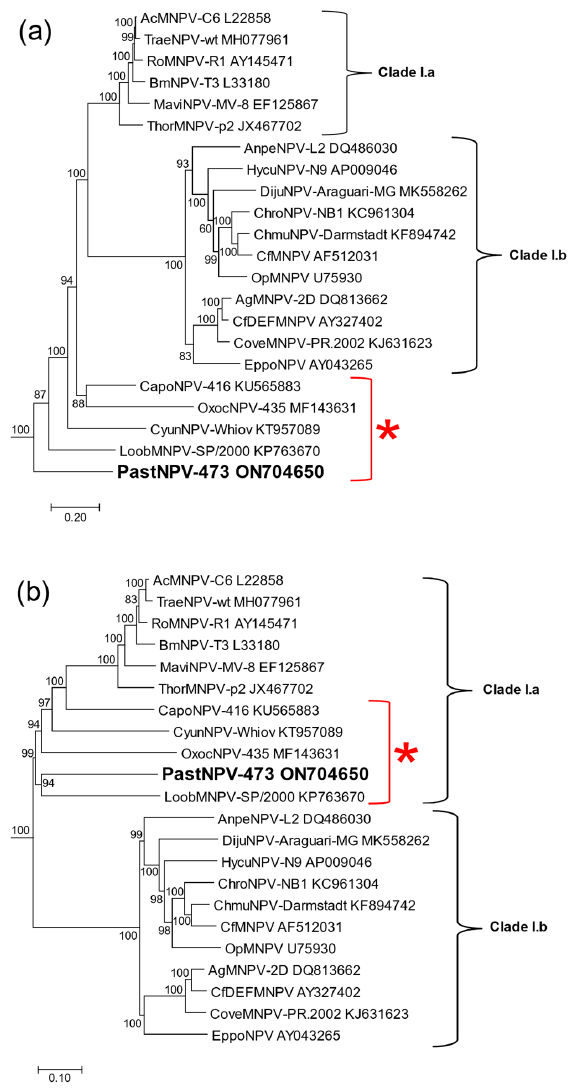
Figure 3. Phylogeny of alphabaculoviruses in the group I clade. ( a ) A subtree of the group I alphabaculoviruses, derived from a phylograms inferred from concatenated MAFFT alignments of baculovirus core gene amino acid sequences by maximum likelihood. ( b ) A subtree of group I alphabaculoviruses derived from a phylogram inferred from MUSCLE alignments of baculovirus core gene amino acid sequences inferred by minimum evolution. Both subtrees show the level of bootstrap support for each branch. Abbreviations and Genbank accession numbers of viruses in the tree are provided; the viruses used in this analysis are listed in Table S1. Clade I.a and I.b are indicated by brackets, and a red bracket and asterisk denotes a group of five alphabaculoviruses with variable placement in the ( a , b ) group I subtrees. PastNPV-473 is indicated in bold type. The branch lengths in all three phylograms suggested that PastNPV represents a new species in genus Alphabaculovirus . The ranges of Kimura-2-parameter pairwise nucleotide distances in alignments of lef-8 , lef-9 , and polh between PastNPV-473 and alphabaculoviruses were estimated as 0.860–2.092 ( lef-8 ), 0.400–2.330 ( lef-9 ), and 0.468–1.205 ( polh )